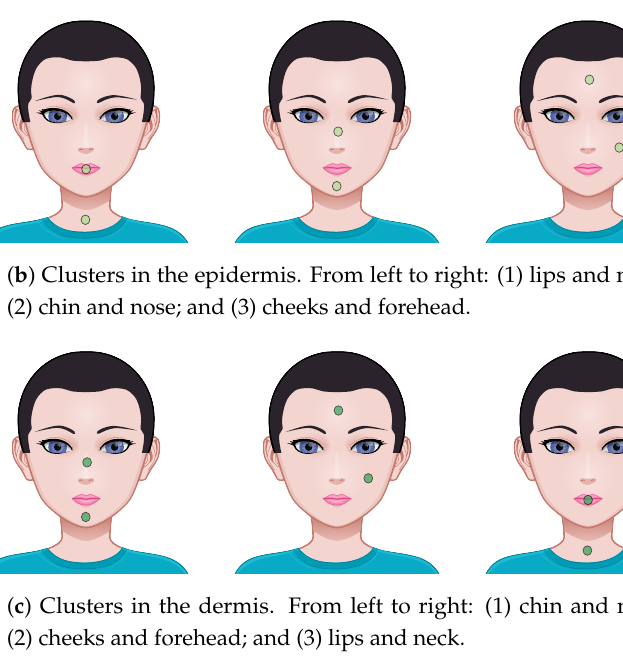
Figure 9. Cluster analysis on the distribution of the skin thickness in the stratum corneum, epidermis and dermis. In each subfigure the clusters are shown from left to right in descending order of average